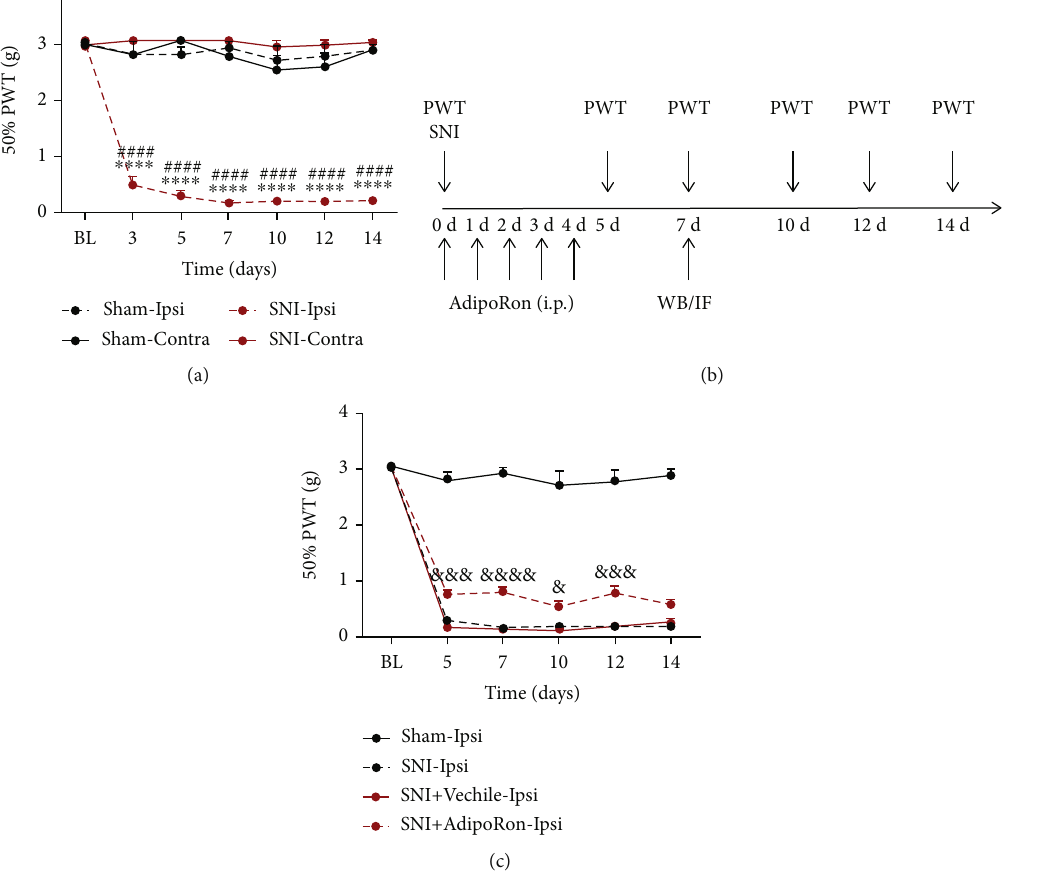
Figure 1: AdipoRon increased 50% PWT in SNI mice. (a) The 50% PWT in the ipsilateral (Ipsi) and contralateral (Contra) hind paw of Sham or SNI mice before and after surgery. (b) Timeline of in vivo experiments. (c) The ipsilateral 50% PWT in SNI mice at all time points after intraperitoneal injection of AdipoRon or Vehicle. All results were presented as mean ± SEM ( n = 6 per group). ∗∗∗∗ p < 0 : 0001 vs. SNI-Contra, #### p < 0 : 0001 vs. Sham-Ipsi, and & p < 0 : 05 , &&& p < 0 : 001 , and &&&& p < 0 : 0001 vs.